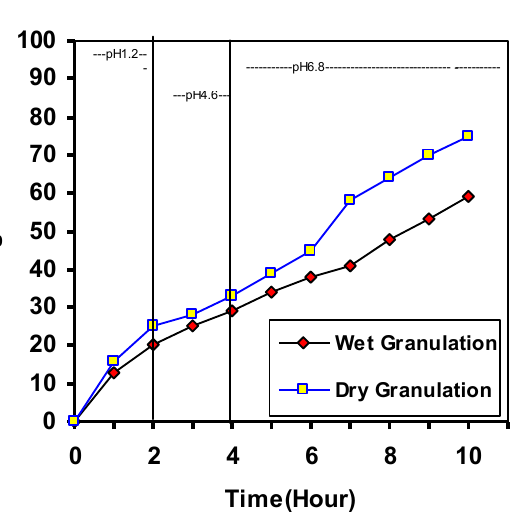
Figure 6. Effect of preparation method on the cumulative release of PTX from selected formula 14 at different pH